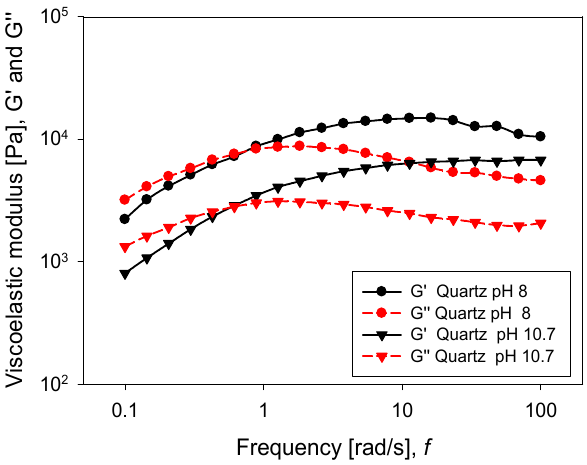
Figure 11. Frequency sweep for quartz slurries at di ff erent pH levels.